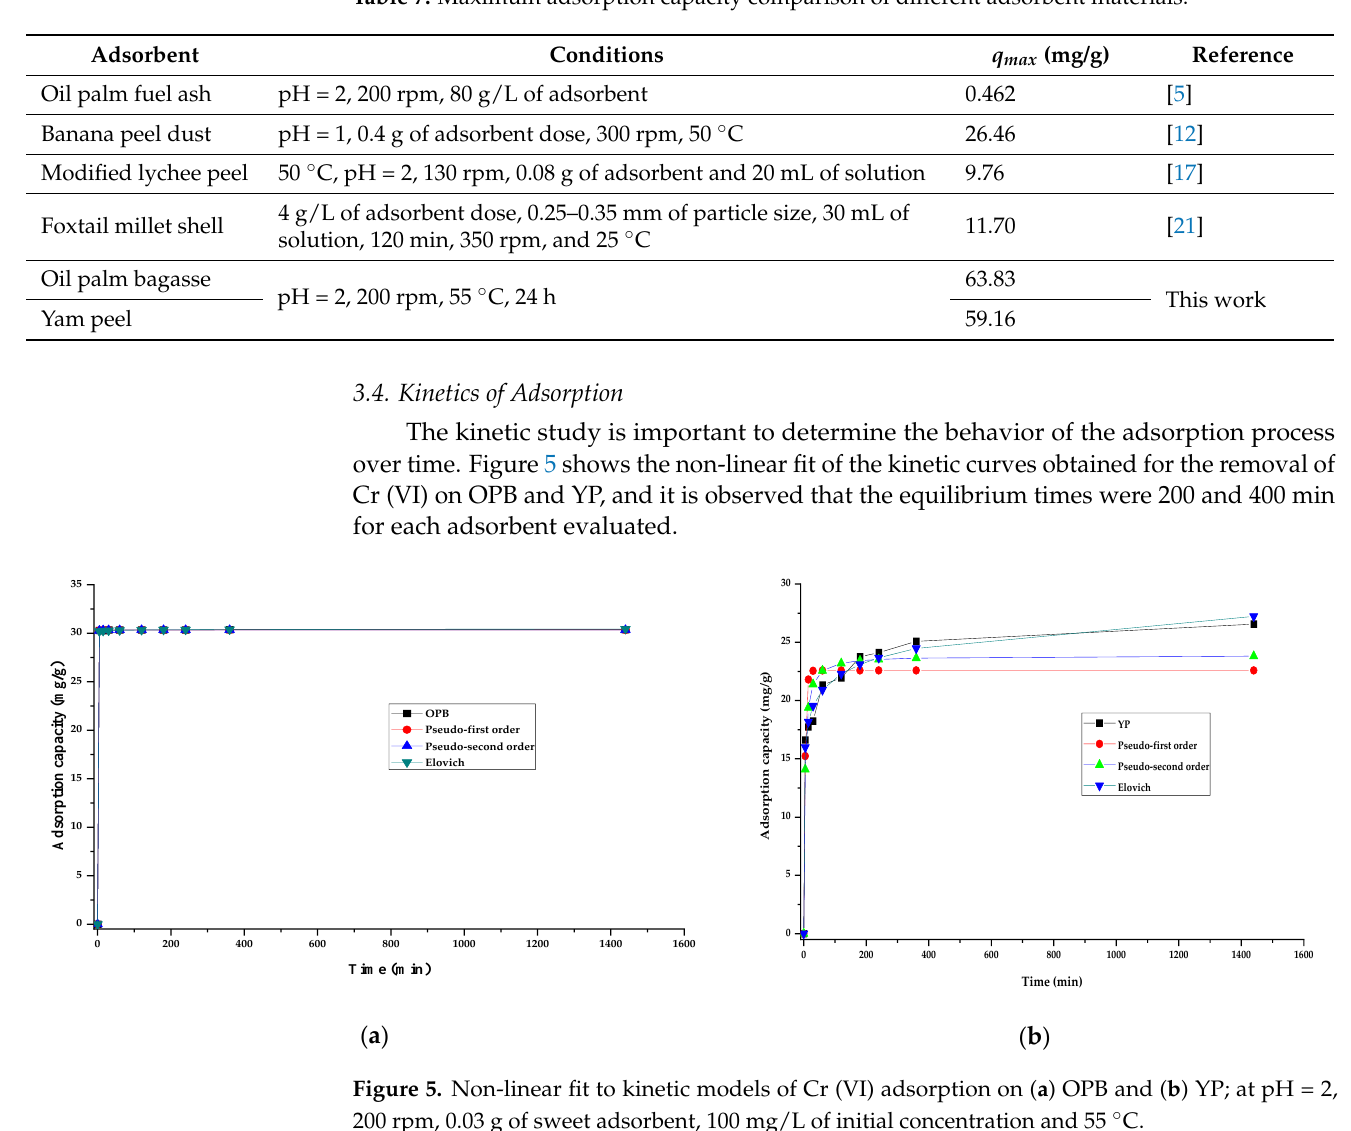
Table 7. Maximum adsorption capacity comparison of different adsorbent materials.